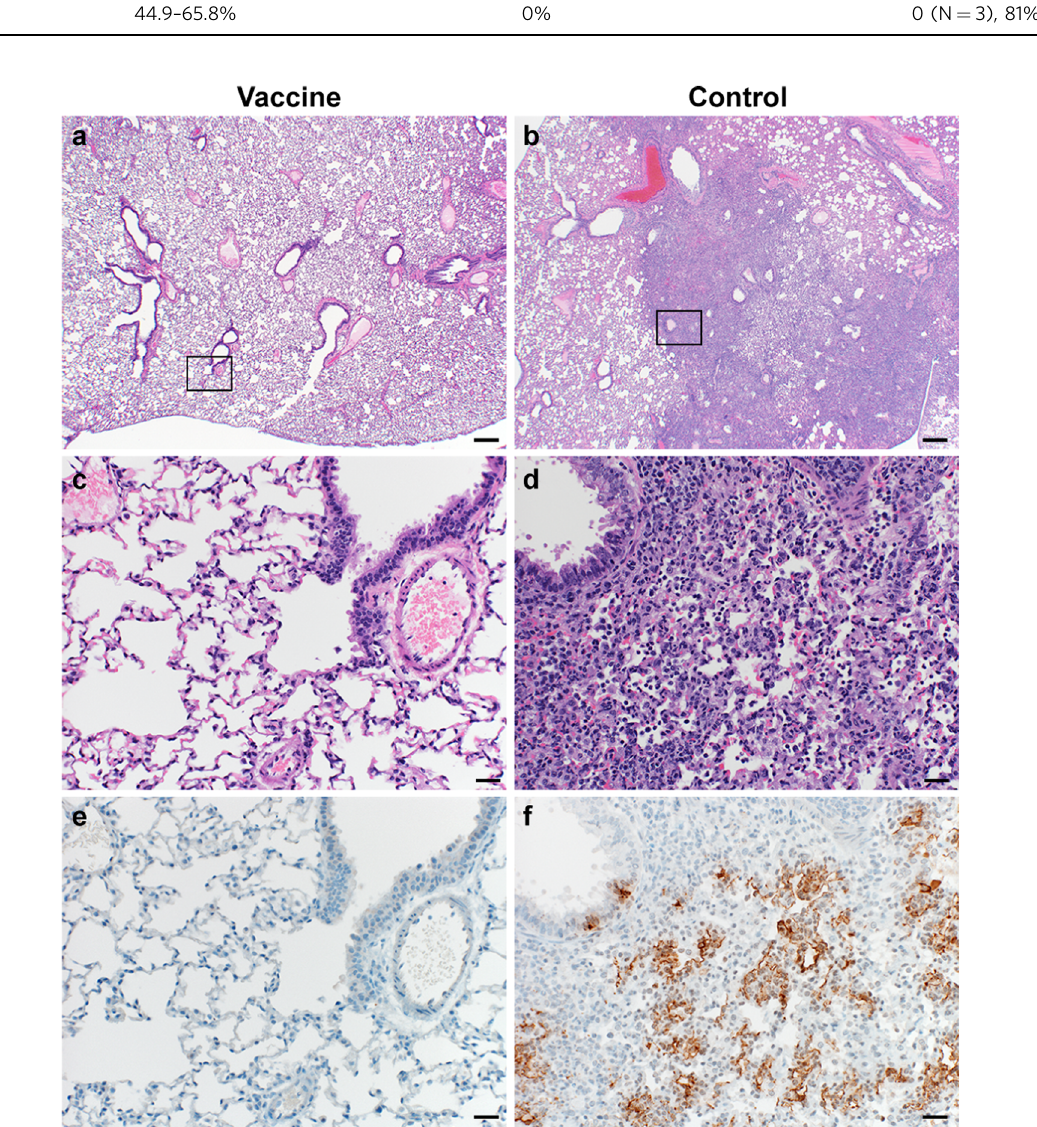
Fig. 5 Pulmonary effects of direct intranasal challenge with SARS-CoV-2 variant B.1.351 in Syrian hamsters at 5 DPI. a – b H&E staining, 20x, scale bar = 200 µ m; a no pathology. b Focally extensive areas of bronchointerstitial pneumonia. c , d H&E staining, 200x, scale bar = 20 µ m; c no pathology. d Bronchointerstitial pneumonia with alveolar histiocytosis, fi brin, and edema. e , f IHC staining against SARS-CoV-2 (brown) 200x, scale bar = 20 µ m; e no staining. f Staining of bronchiolar epithelial cells, type I&II pneumocytes, and rare macrophages. Micrographs are representative of what was observed viewing 100% of a single 5 µ m section of the complete lungs containing all lobes for each of four Hamsters vaccinated with ChAdOx1 nCoV-19 via the intra- nasal route are protected against lower respiratory tract infection with B.1.351 . Intranasal vaccination of hamsters with ChAdOx1 nCoV-19 resulted in a reduction of shedding of SARS- CoV D614G 4 . We hypothesized that a similar reduction in shed- ding would be found upon inoculation with B.1.351. Animals were vaccinated with 2.5 × 10 8 IU ChAdOx1 nCoV-19/animal, either via the intranasal route or via the intramuscular route. New stock of B.1.351 was obtained, and next-gen sequencing revealed no SNPs in the spike protein (isolate hCoV-19/USA/MD-HP01542/2021) from here on referred to as B.1.351-2. Sixty days post vaccination,